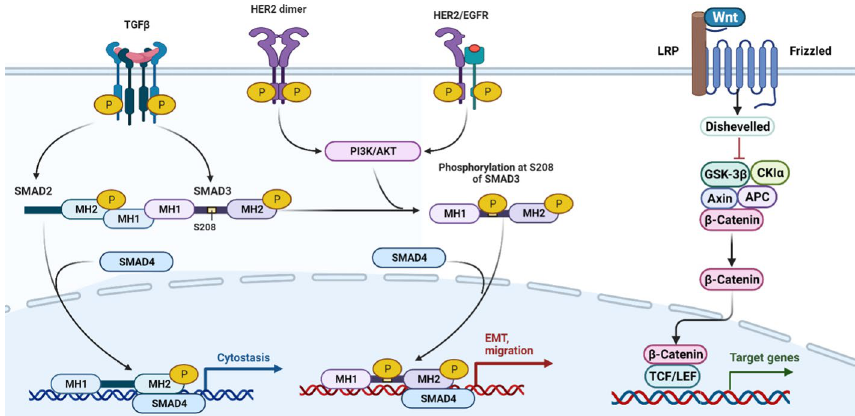
Fig. 1 HER2 and Wnt/β‑catenin signaling are two essential pathways with essential roles in the progression of breast cancer cells. HER2 signaling exerts its function via dimerization and thereby activation of various other pathways, such as PI3K/AKT, leading to EMT migration and, thus, cancer progression. The function of TGFβ can culminate in cytostasis and prevent cancer progression. Even though it can enhance phosphorylation as S208 of SMAD3, it amplifies the PI3K/AKT signaling pathway to promote breast cancer. In addition, the Wnt/β‑catenin pathway can act as a breast cancer promoter and exacerbate the disease by entering β‑catenin into the nucleus and affecting